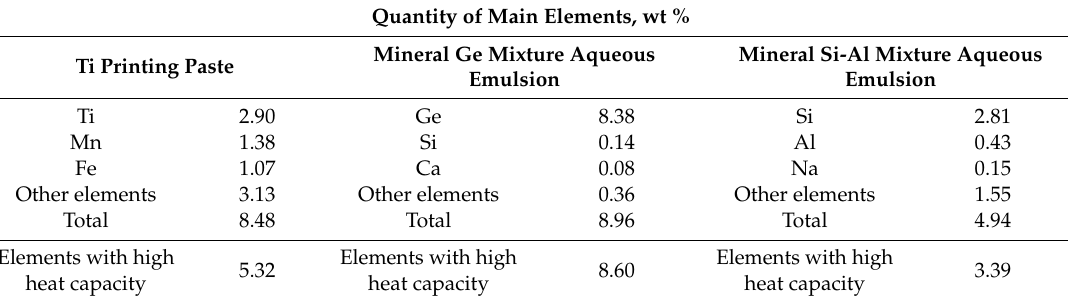
Table 3. XRF element analysis of main bioceramic additives.